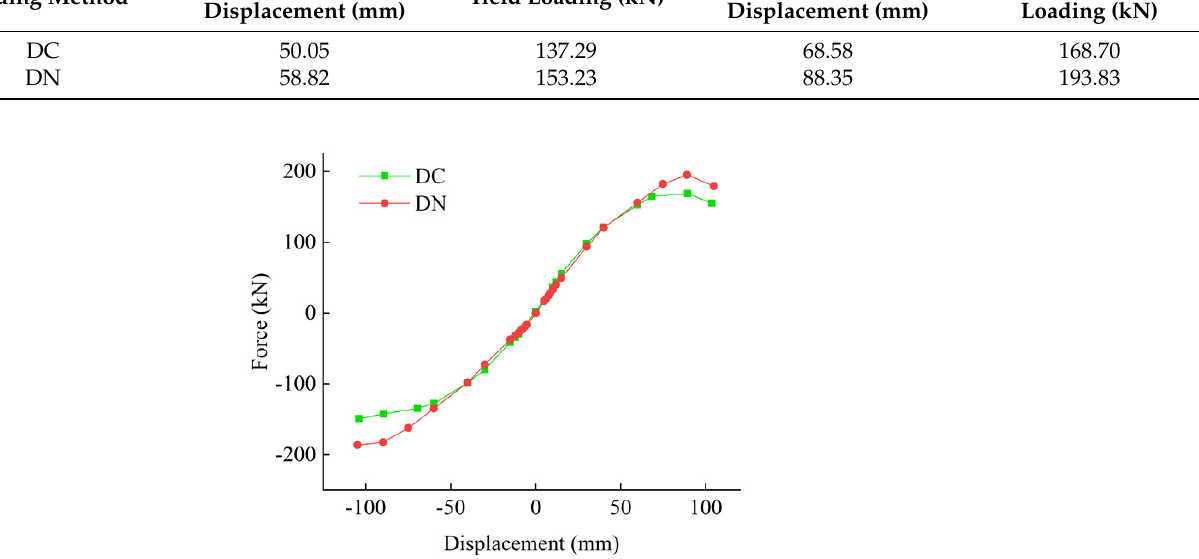
Figure 14. Skeleton curves of specimens DC and DN.